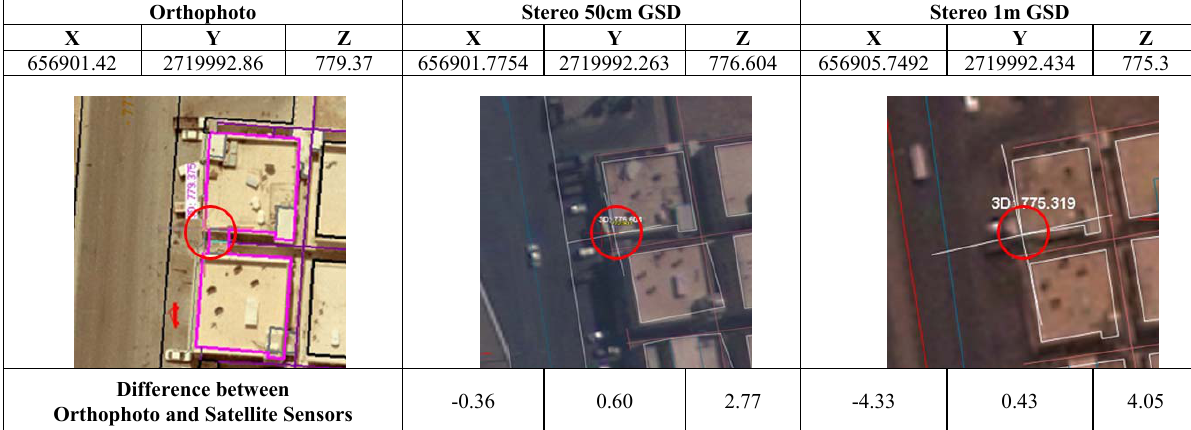
Table 1e. showing capturing of building corner based on different resolutions of Stereopairs.